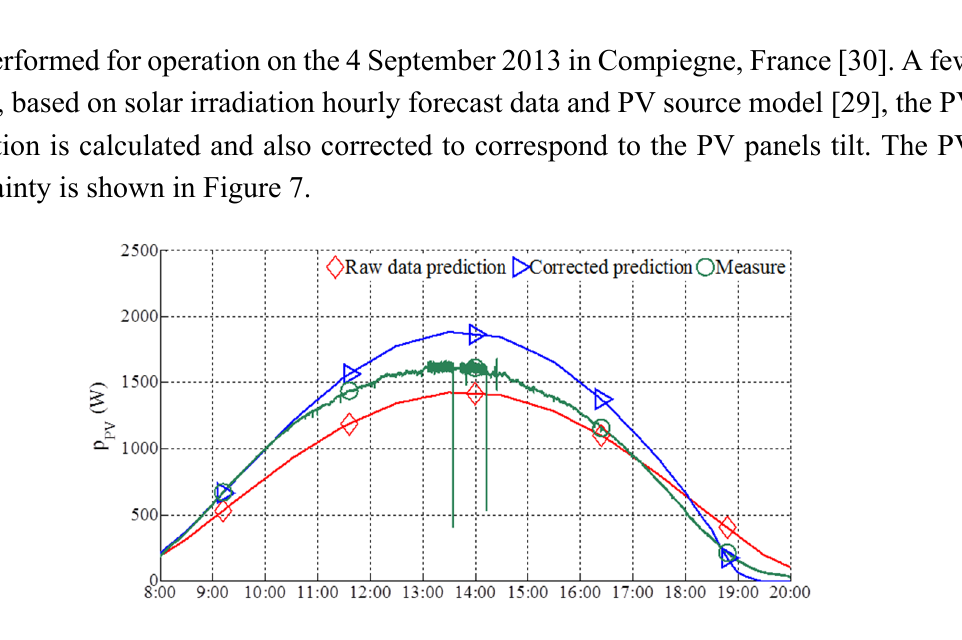
Figure 7. PV sources power prediction for experiment and PV sources power measure for Test